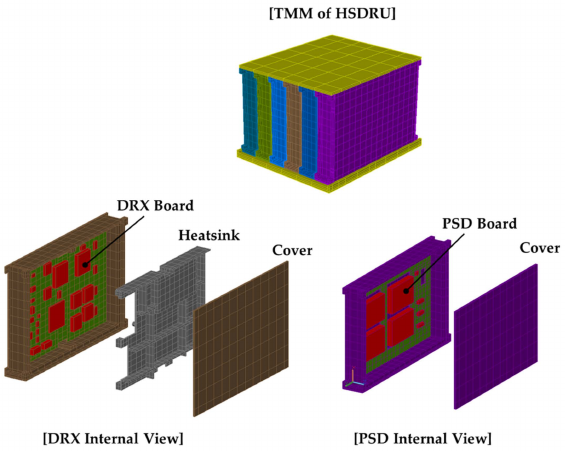
Figure 5. TMM of